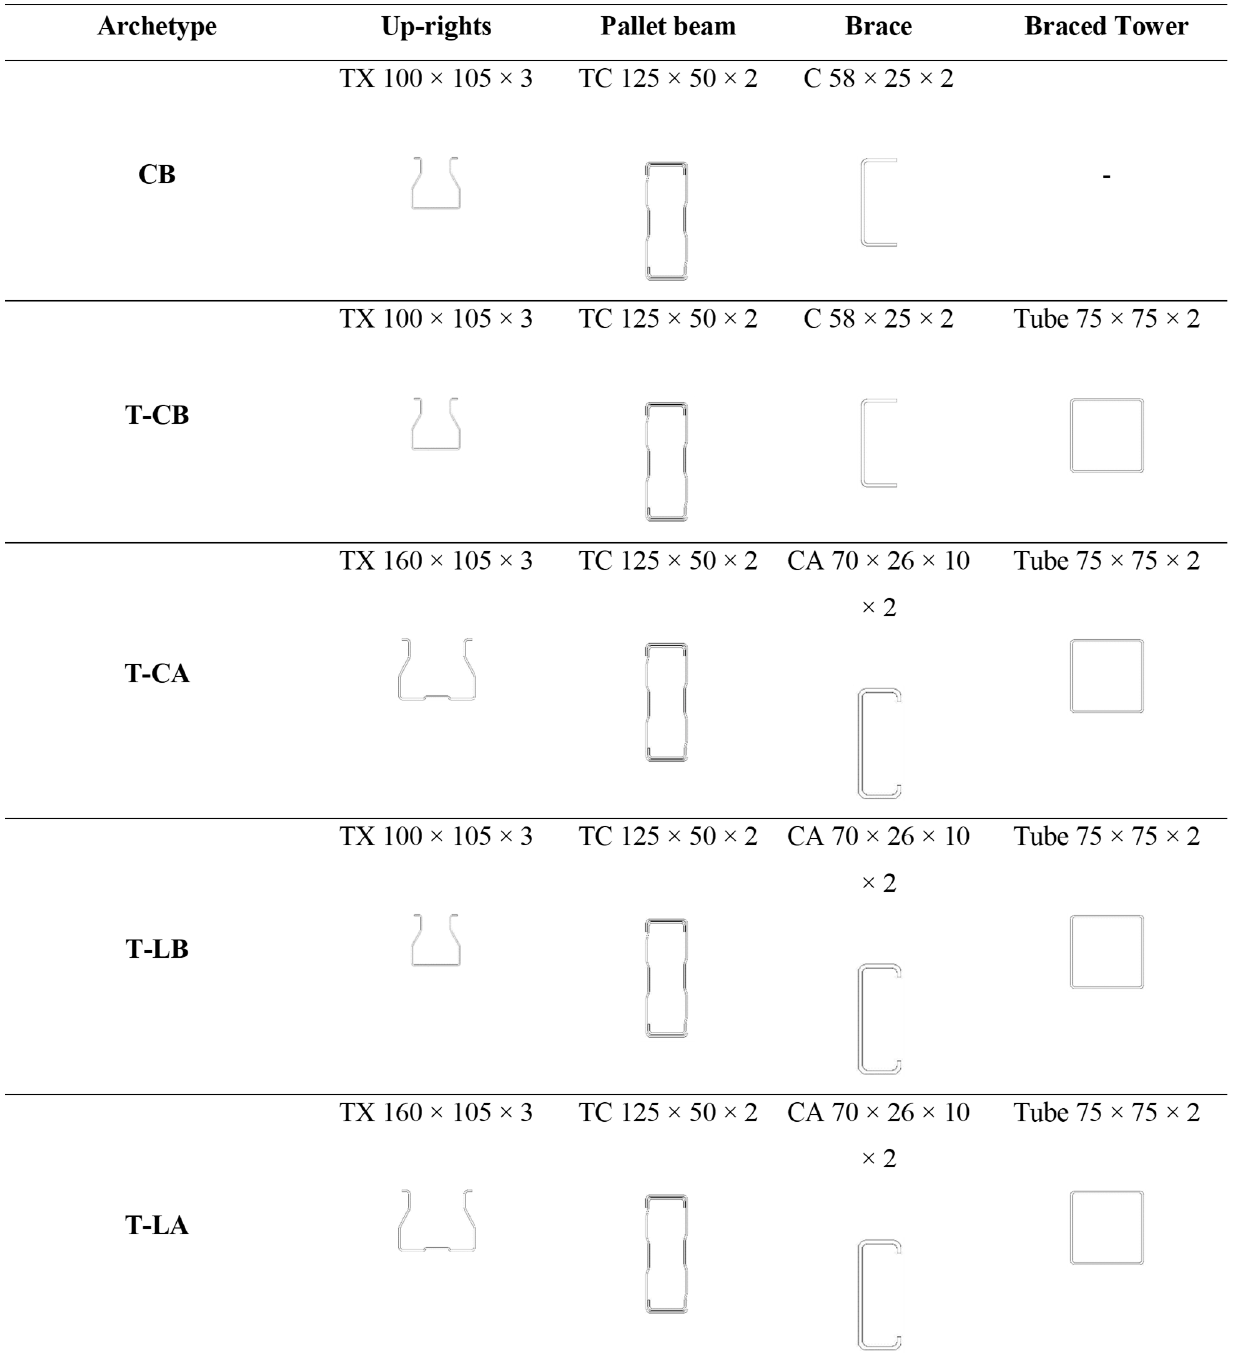
Figure 2. Summary of dimensional properties of rack members and type of archetype (dimensions in millimeters).